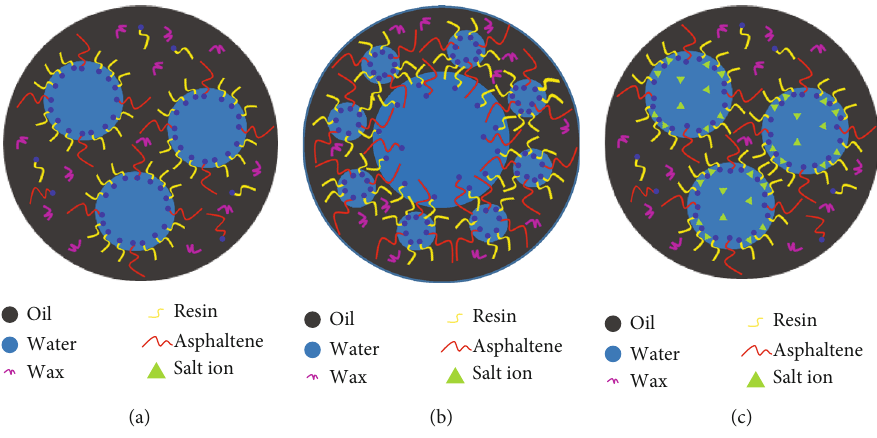
Figure 11: Schematic diagram of the mechanism of heavy oil-water emulsi fi